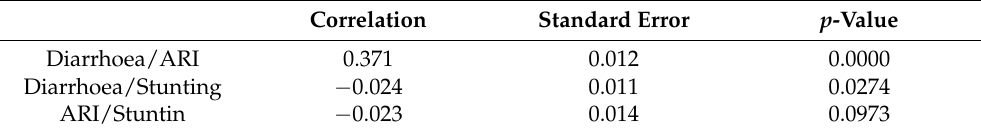
Table 3. Tetrachoric correlation among acute respiratory infection, diarrhoea, and